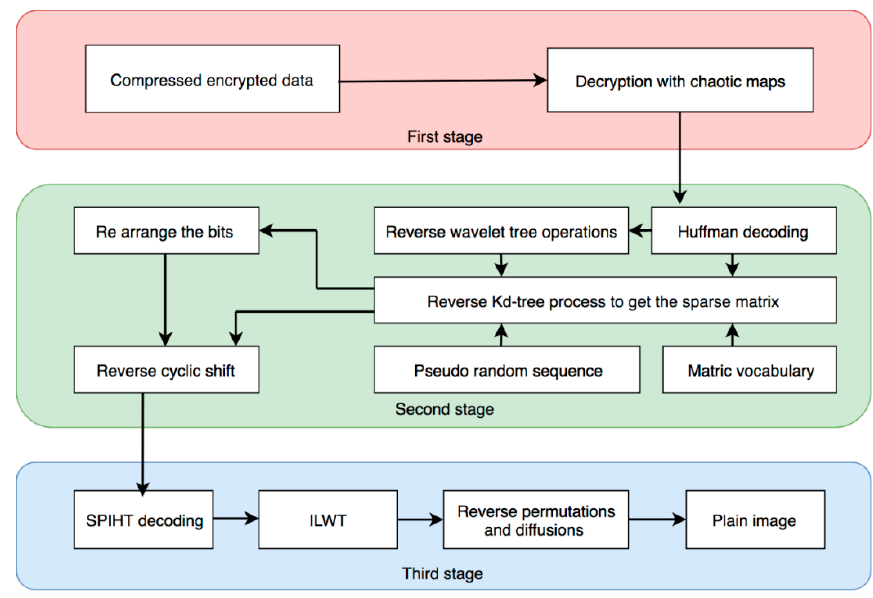
Figure 6. Reverse encryption and compression process.